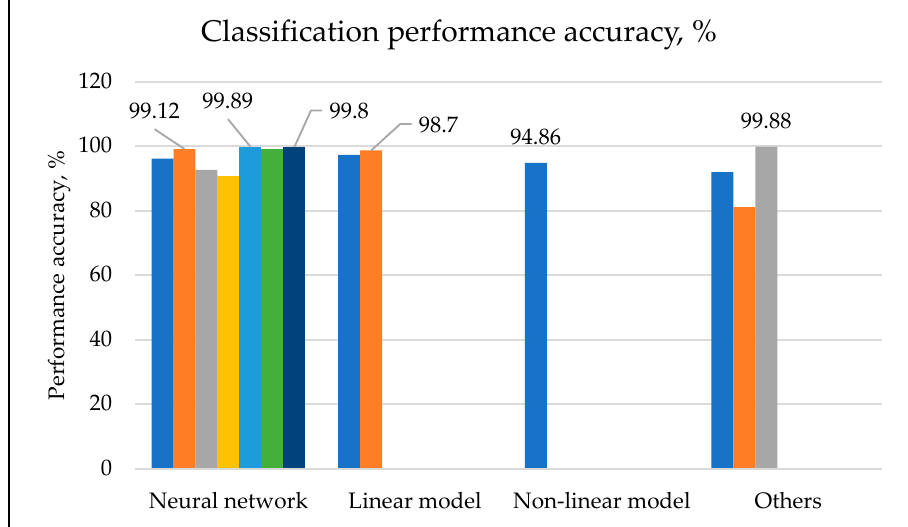
Figure 3. Graph of classification performance accuracy.